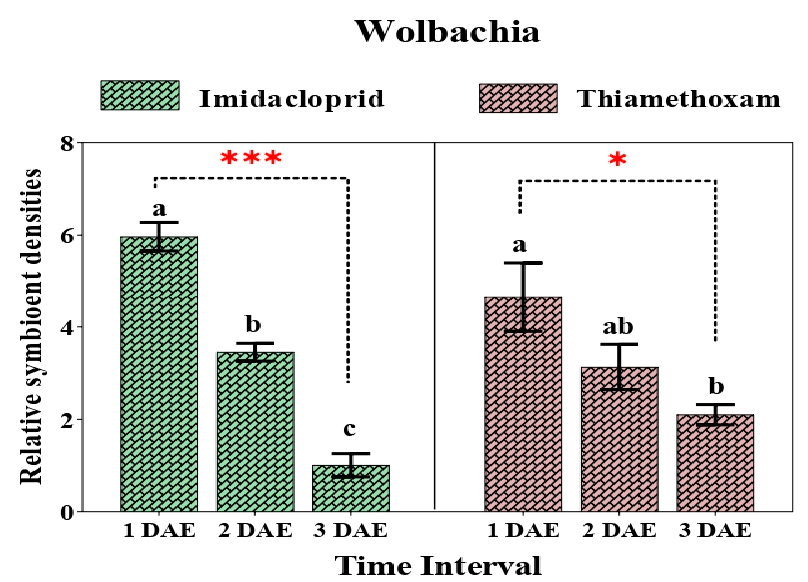
Figure 5. Relative density of Wolbachia in whiteflies after exposure to sublethal doses of imidacloprid 17.8 SL and thiamethoxam 25 WG at various durations (1 DAE, 2 DAE, and 3 DAE). Bars represent the standard error of the mean (SEM), and the different letters indicate statistically significant differences between the treatments. p ≤ 0.05 is indicated by * and p ≤ 0.001 is indicated by ***. DAE, days after